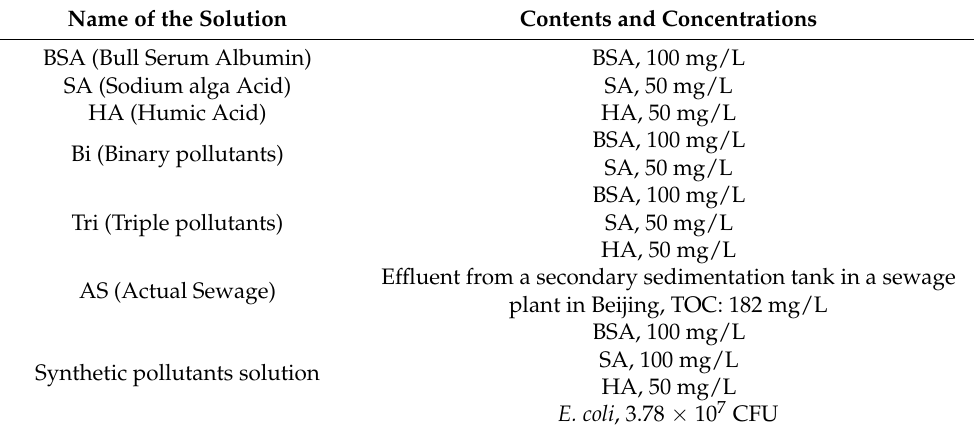
Table 1. Composition of pollutant